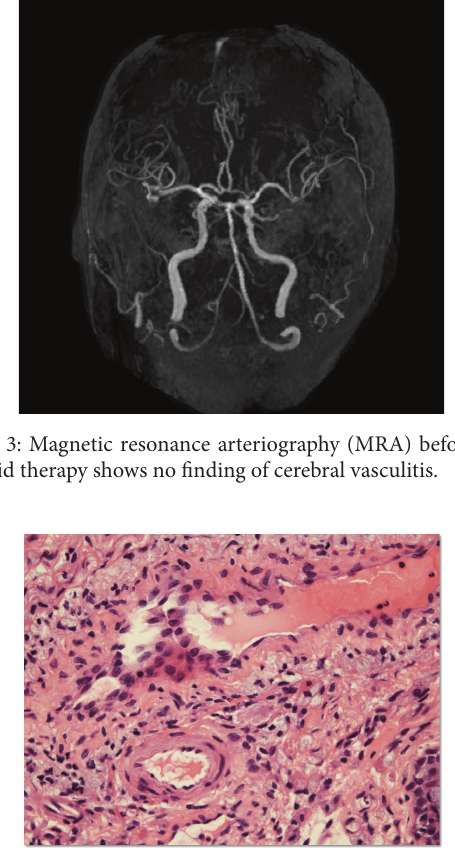
Figure 4: Histology of the left choroidal tumor showing vasculitis of a small-sized artery. Choroidal tumor biopsy specimens showing necrotizing vasculitis with aggregate of inflammatory cells (hema- toxylin and eosin